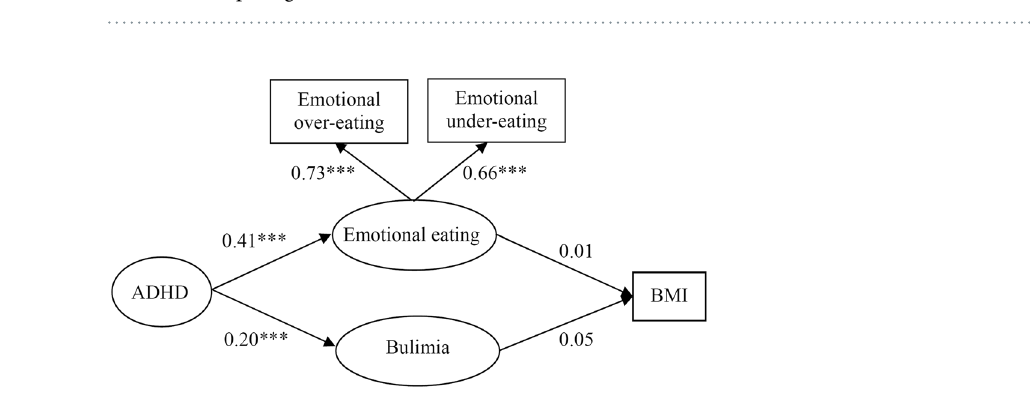
Table 4. Comparing model 1 with model 2 in model fitness indices.